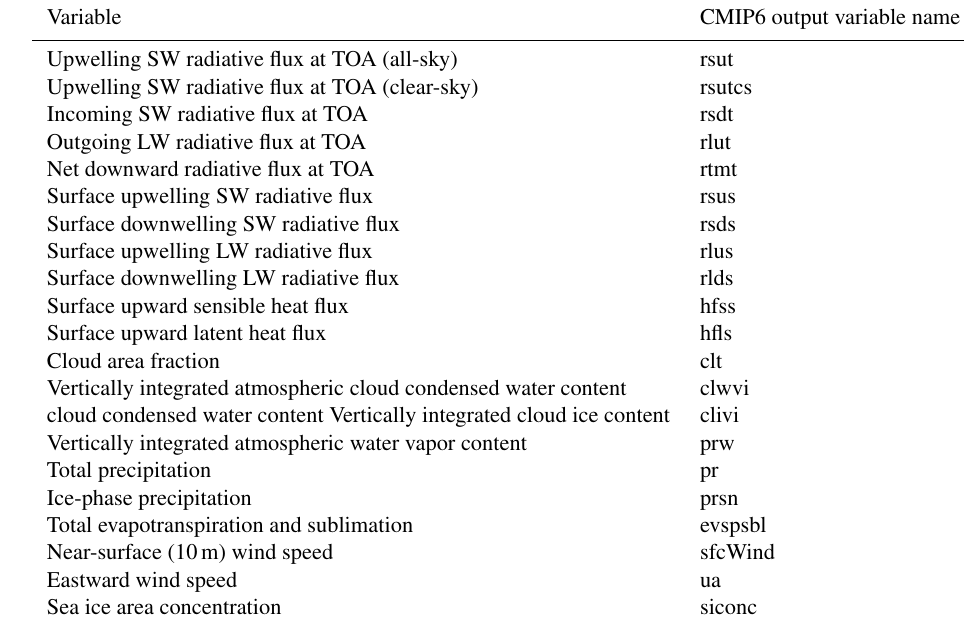
Table A1. Variables used in this study and their CMIP6 standard short